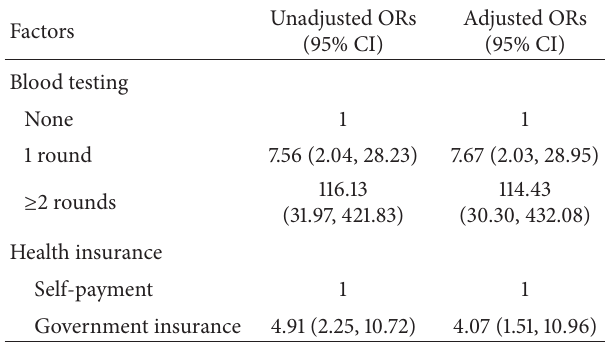
Table 1: Characteristics of patients at the emergency department (ED) categorized by time spent at the ED.